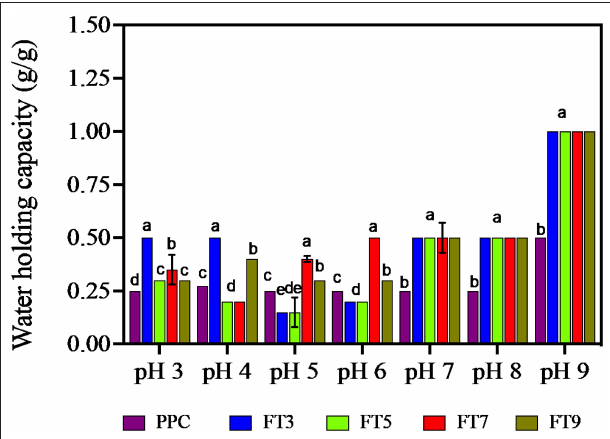
FIGURE 7 | Water holding capacity (g/g) of pea protein concentrate (PPC) and > 50 protein aggregates. PPC was heated at 100 ◦ C and varying pH, centrifuged and the supernatant passed consecutively through 30 and 50 kDa membranes. The final retentate from the 50 kDa membrane were collected as FT3, FT5, FT7, and FT9 for heat treatments at pH 3.0, 5.0, 7.0, and 9.0, respectively. Bars with different letters have different mean values ( p < 0.05).